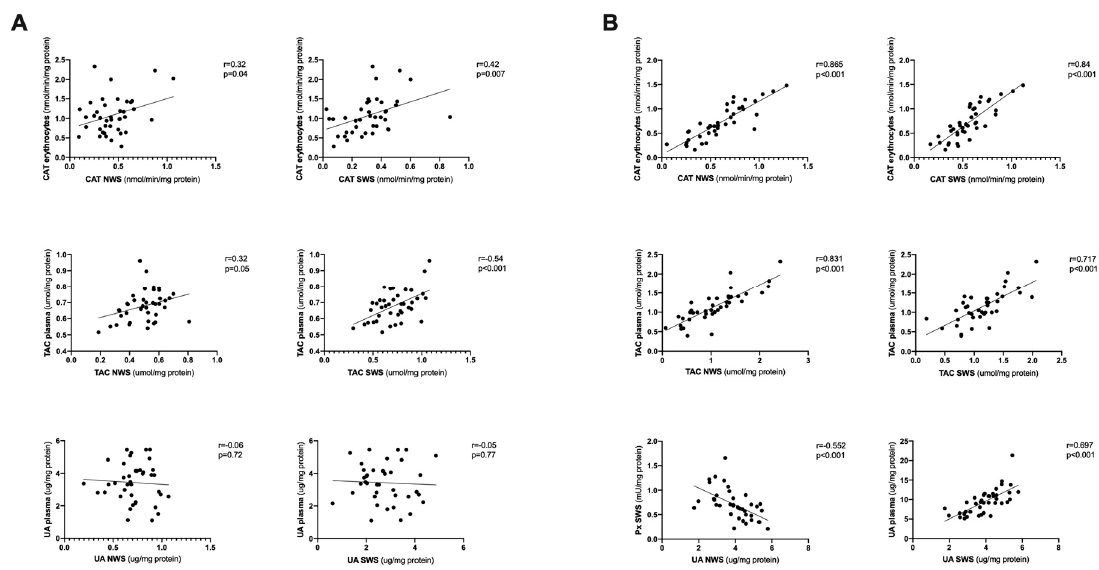
Figure 7. Saliva–blood correlations of the analyzed redox biomarkers in healthy controls ( A ) as well as overweight and obese adolescents ( B ). CAT- catalase, NWS- non-stimulated whole saliva, SWS- stimulated whole saliva, TAC- total antioxidant capacity, UA- uric acid. Correlations between BMI and salivary redox biomarkers and presented in Figures 8 and 9. Interestingly, BMI correlates with most salivary antioxidants and oxidative damage products but only in the study